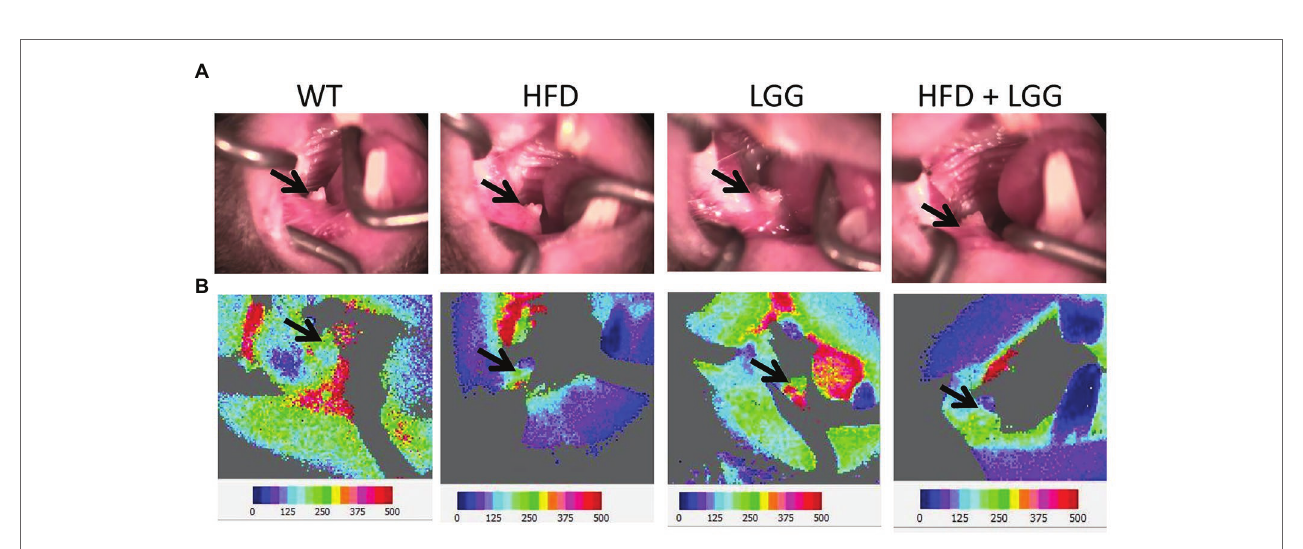
FIGURE 7 | Effect of HFD and LGG treatment on the gingival blood flow. WT, Wild-type C57BJ/L6 mice; HFD, HFD-supplemented wild-type mice; LGG, LGG- supplemented wild-type mice; HFD + LGG, HFD, and LGG-supplemented wild-type mice. (A) Buccal view of the exposed right mandibular gingiva in first molar area. (B) Blood flow imaging at the surface of the buccal right mandibular gingiva in first molar area via Doppler laser. The black arrows indicate the gingival blood flow measurement site.